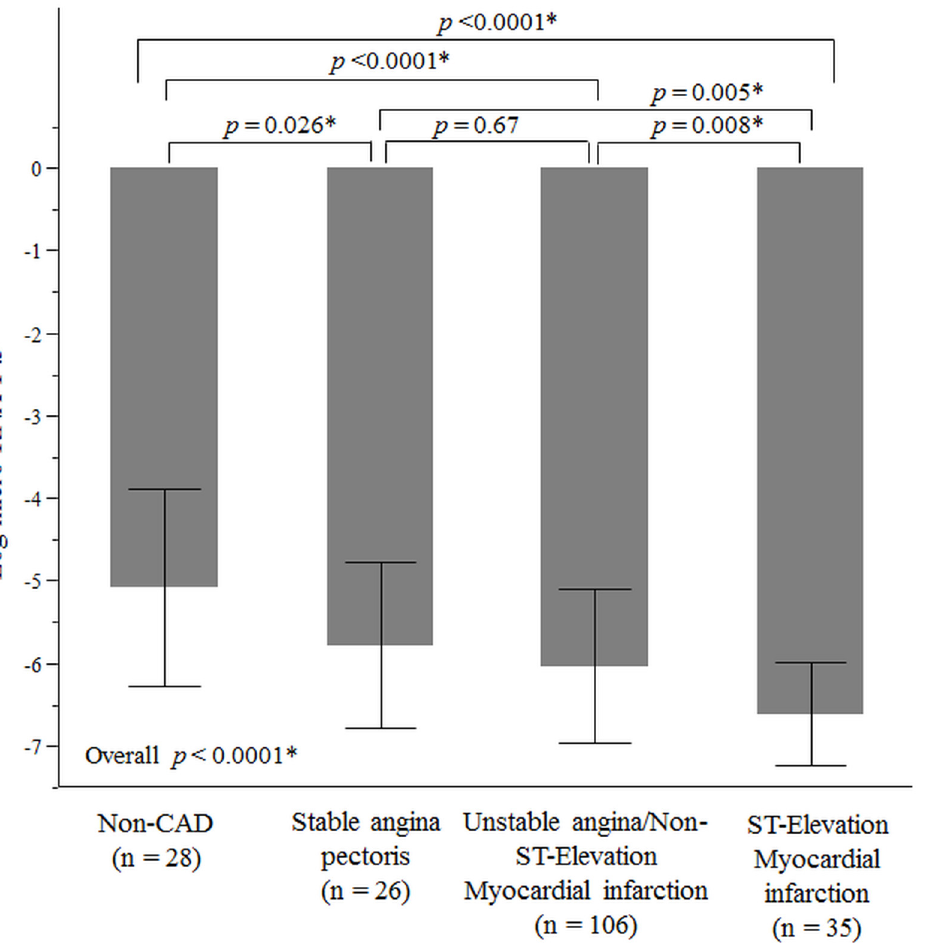
Fig 4. Plasma miRNA-145 levels and clinical presentation of CAD. These bars represent averages of Ln_miRNA-145 values among different clinical presentations of CAD compared with non-CAD patients. T-bars indicate standard deviation. Patients with ST-elevation myocardial infarction had significantly lower values of Ln_miRNA-145 compared with the rest of the groups. Non-CAD subjects had significantly higher Ln_miRNA-145 than patients with CAD. * p < 0.05; CAD, Coronary artery disease; RNA, Ribonucleic acid.